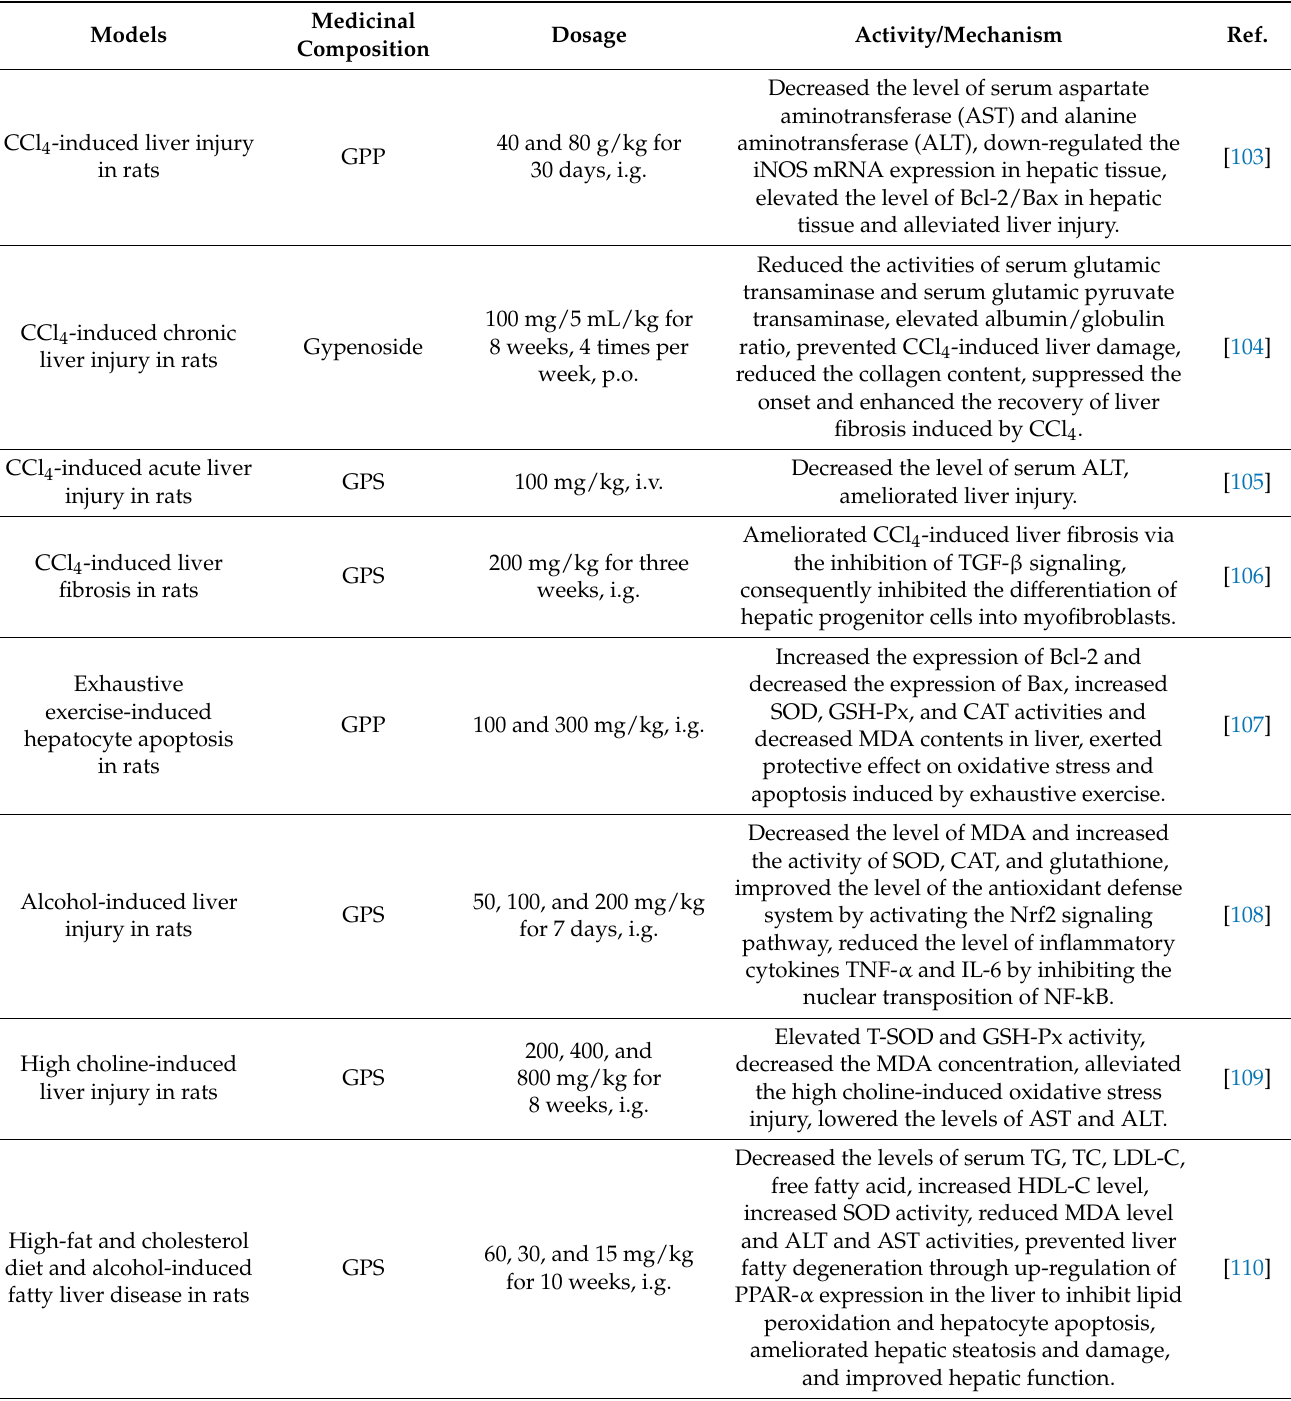
Table 5. Hepatoprotective effects of